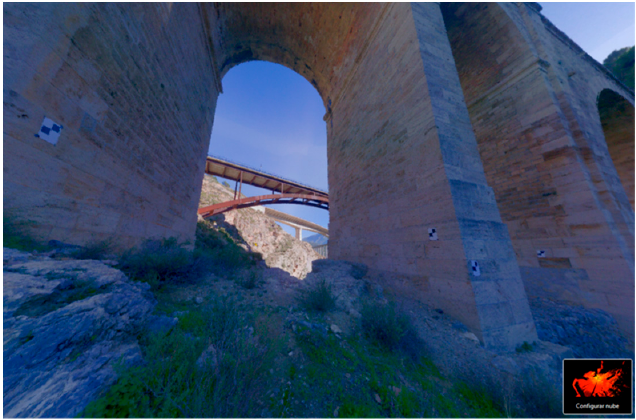
Figure 7. Targets used to register the BLK360 scan stations .